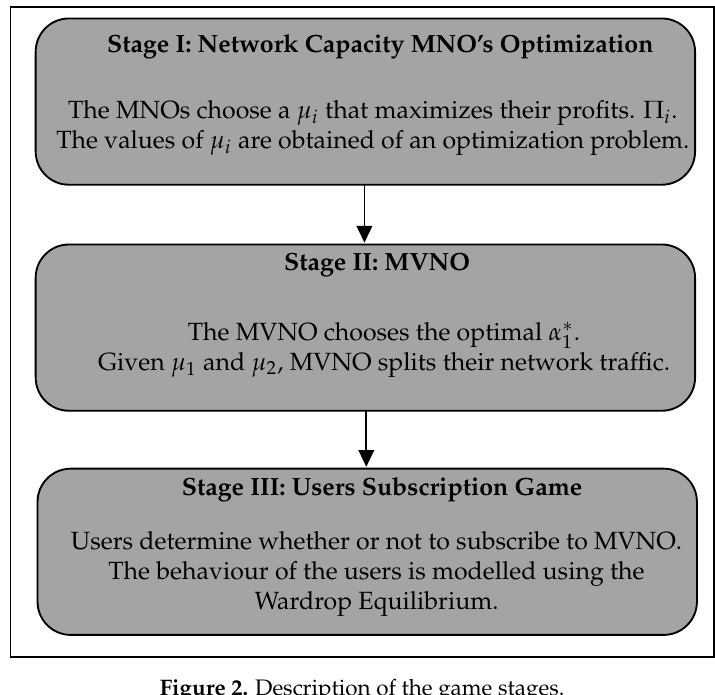
Figure 2. Description of the game